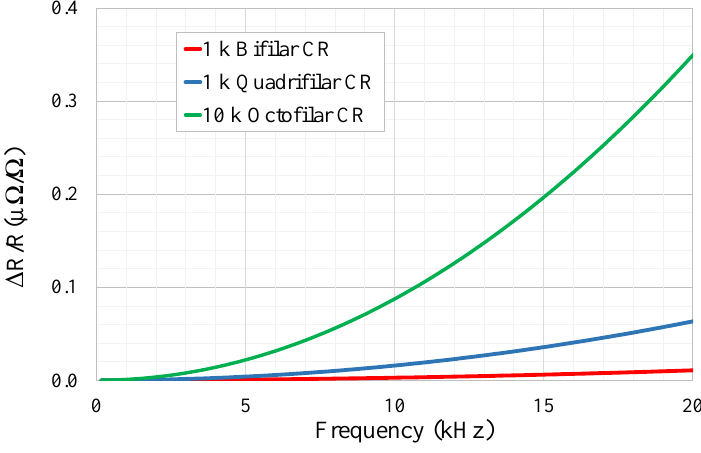
Figure 5. Calculated frequency performance of the bifilar, quadrifilar, and octofilar